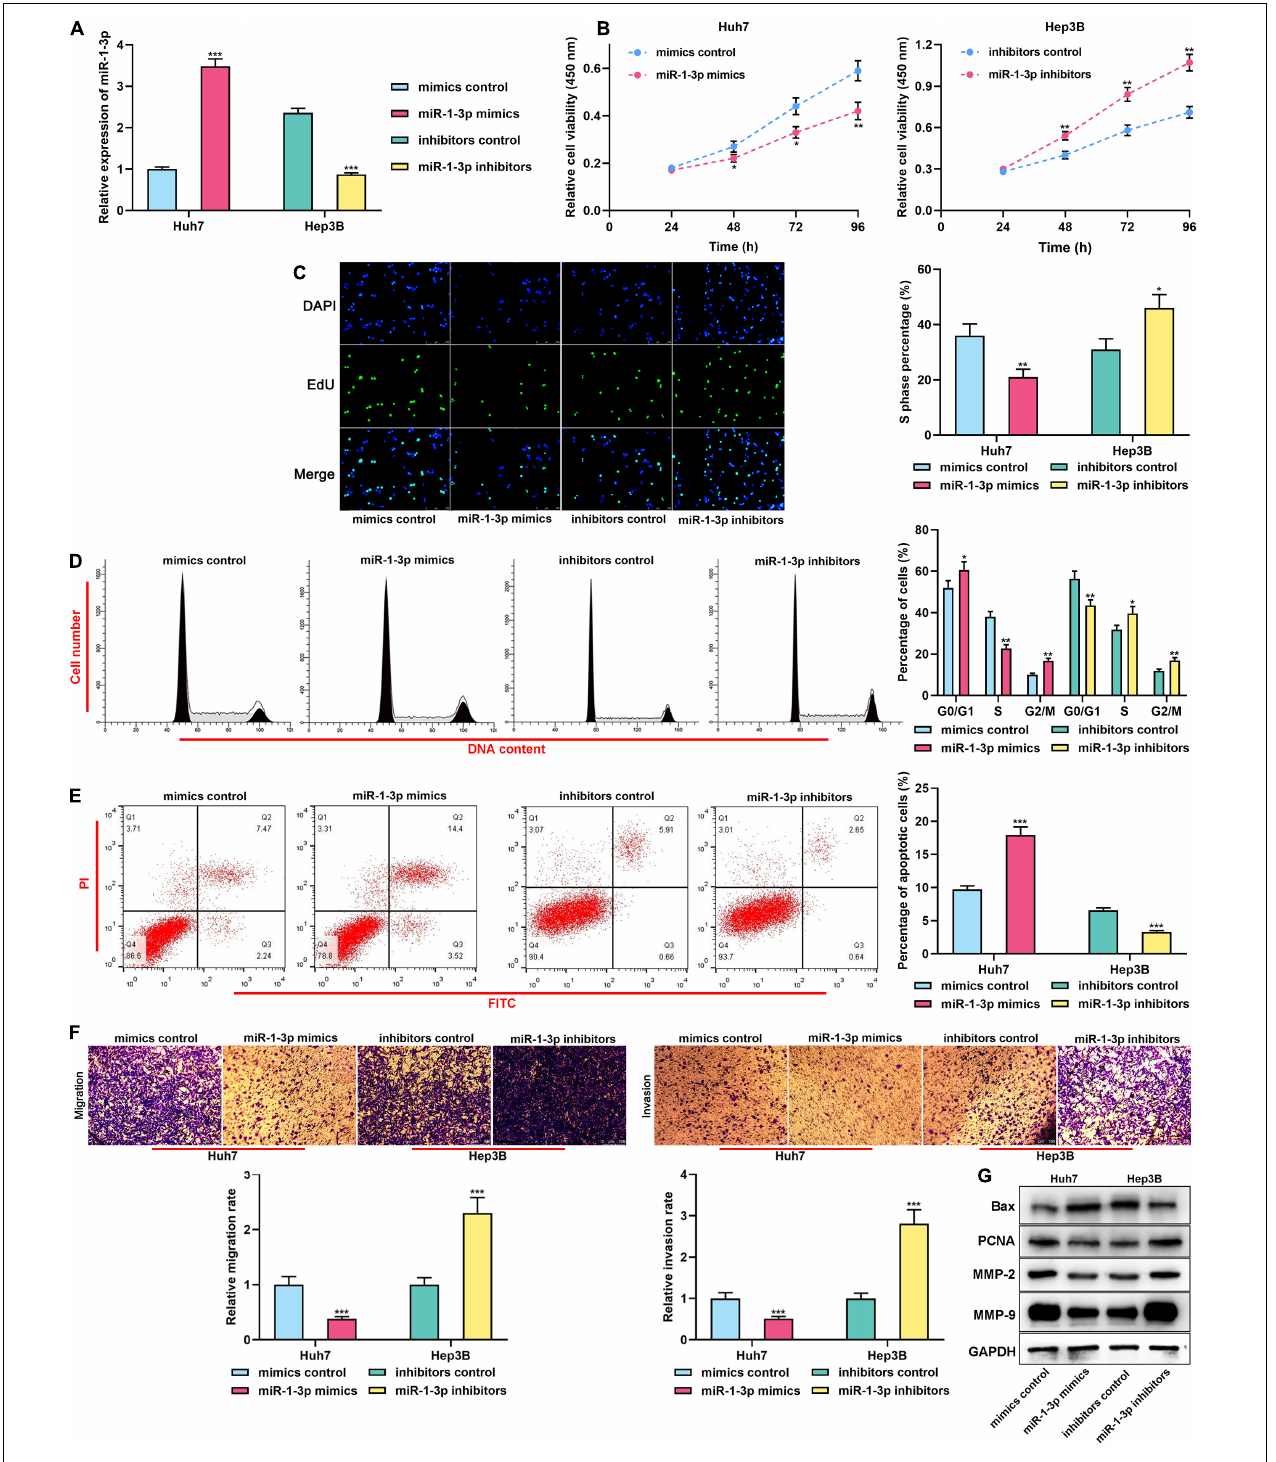
FIGURE 2 | MiR-1-3p inhibited the proliferation, migration, and invasion and promoted apoptosis of HCC cells. (A) The transfection efficiency of miR-1-3p mimics and miR-1-3p inhibitors was examined using qRT-PCR. (B) After the transfection, the proliferation of Huh7 and Hep3B cells was detected utilizing the CCK-8 assay. (C) After the transfection, EdU assay was performed to determine the proliferation of Huh7 and Hep3B cells. (D) After the transfection, flow cytometry was performed to analyze the cell cycle distribution of Huh7 and Hep3B cells. (E) After the transfection, apoptosis of Huh7 and Hep3B cells was measured using flow cytometry. (F) After the transfection, migration and invasion of Huh7 and Hep3B cells were measured through Transwell assay. (G) After the transfection, Western blot was used to detect the expressions of Bax, PCNA, MMP-2, and MMP-9 of Huh7 and Hep3B cells. *, **, *** represent p < 0.05, p < 0.01, and p < 0.001, respectively.